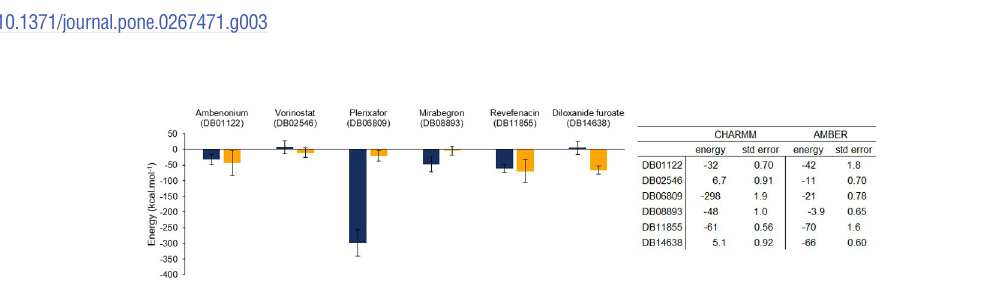
PLOS ONE | https://doi.org/10.1371/journal.pone.0267471 April 22, 2022 12 /